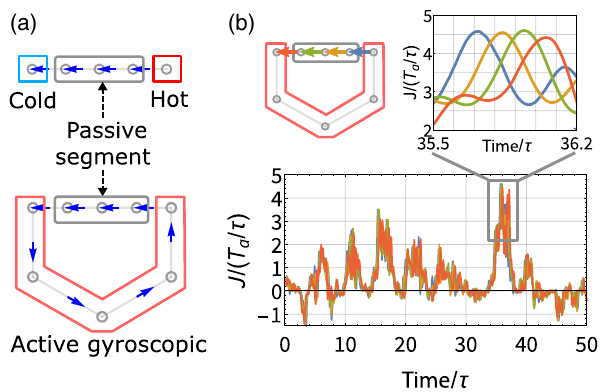
FIG. 4. Driving energy through a passivechain. (a) Conventional energy transport in a passive material (boxed in gray) with temperature differences at two ends. Similarly, the active gyro- scopic network can also drive energy flows through a passive segment. (b) Instantaneous energy flux J through bonds in the passive segment from a simulation. Fluxes through different bonds are colored differently. In general, J is stochastic; however, during the period when J is large, J exhibits successive peaks in accordance with the direction of the flux. In the simulation setup, parameters for the active particles are as follows: m , k k ¼ 10 , ˆ B , T , τ ¼ 1 . Passive particles are constrained to 1D, and a their γ , T , k are set to a g